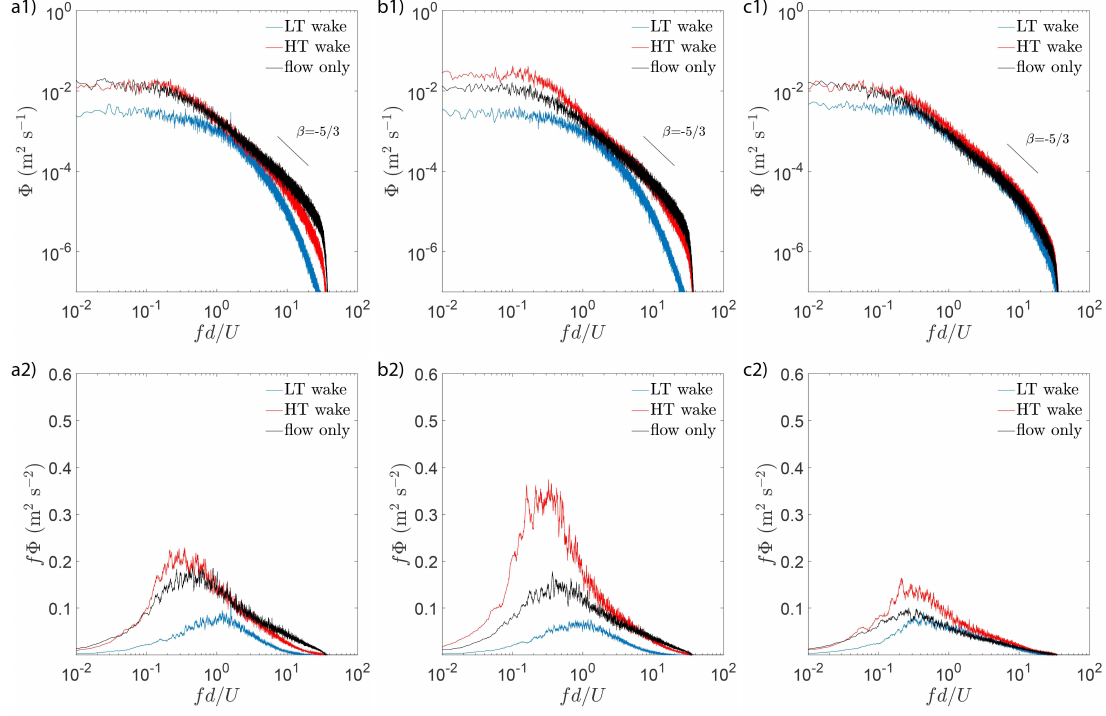
Figure 3. Velocity spectra Φ u at various locations along the axis of the turbine rotor. ( a1 ) x / d = 2; ( b1 ) x / d = 3; ( c1 ) x / d = 10; ( a2 – c2 ) represent the pre-multiplied counterparts of the ( a1 – c1 )